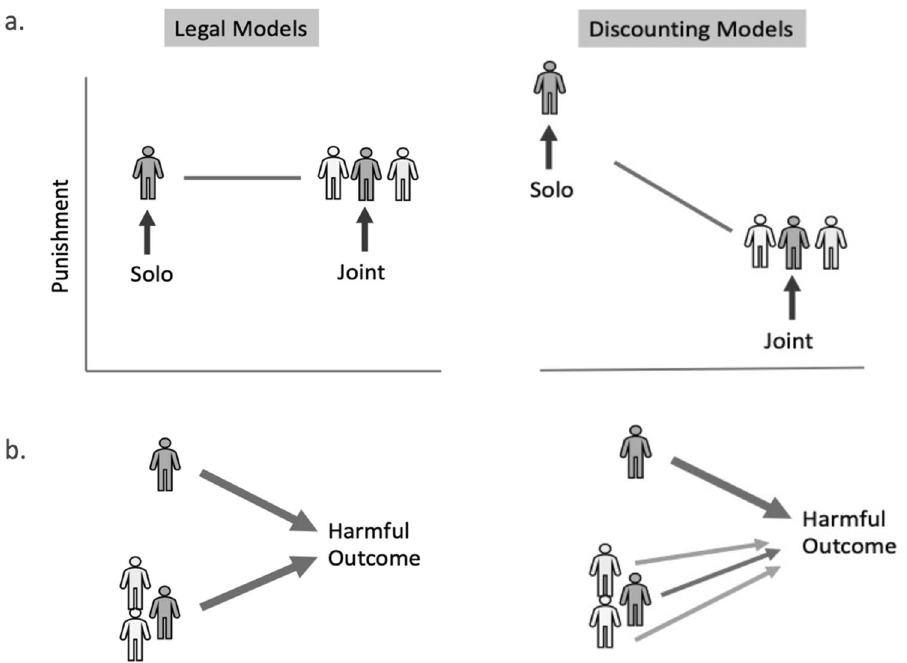
Figure 1. ( a ) Two models of punishment in solo and joint harmful actions: legal models suggest similar punishment for joint and solo acts. Discounting models predict less punishment in joint than solo harm violations (the diffusion of punishment hypothesis) ( b ) Causal links in two models of punishment. In legal models, all perpetrators in joint actions are causally responsible for the harmful outcome to the same degree as in solo actions. In the discounting models (the diffusion of punishment hypothesis), each individual in the group is less causally responsible for the